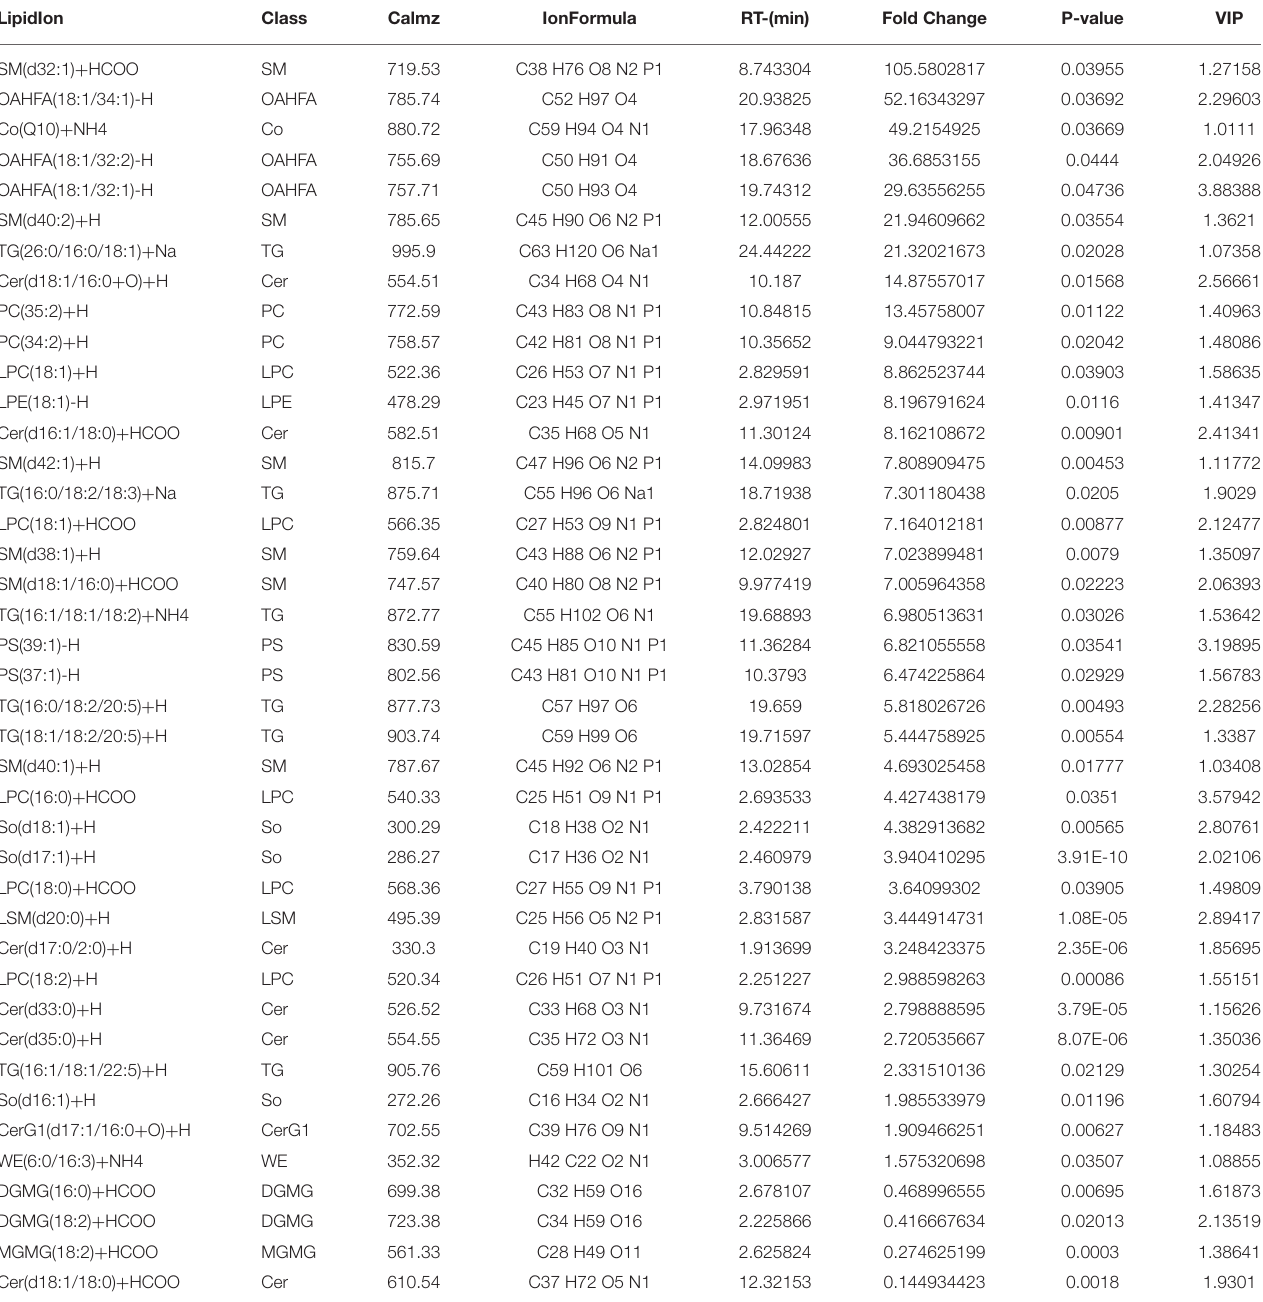
TABLE 2 | Significant different subclasses of lipids of T0( n = 26) verse control ( n =